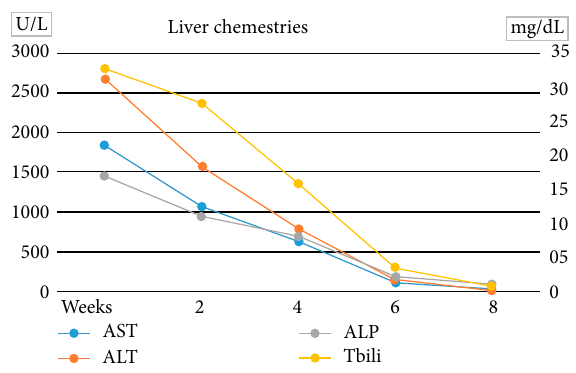
Figure 2: Trend of liver enzymes during admission and in the outpatient